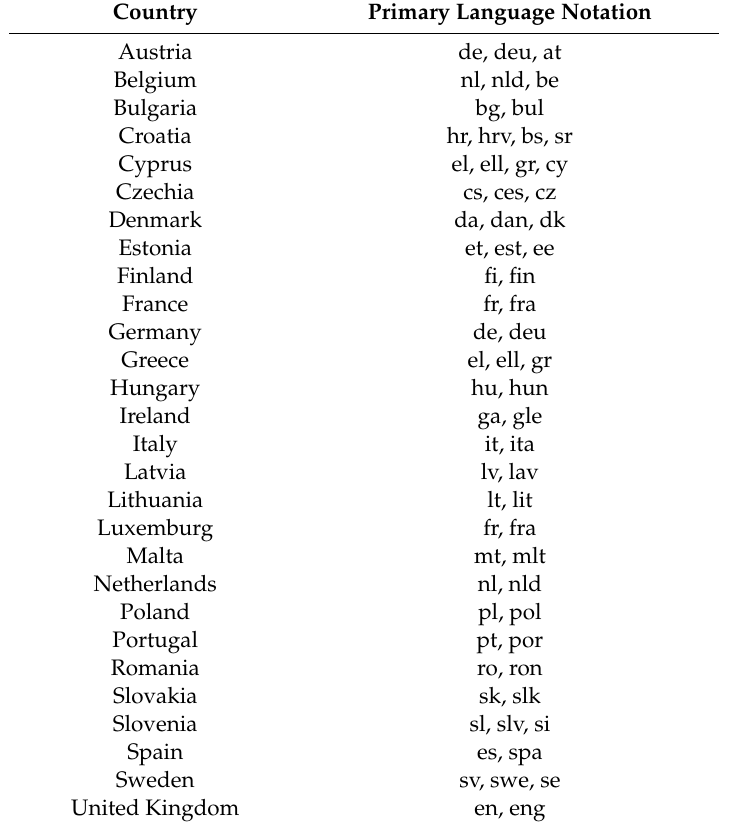
Table 3. Language notations used per countries.